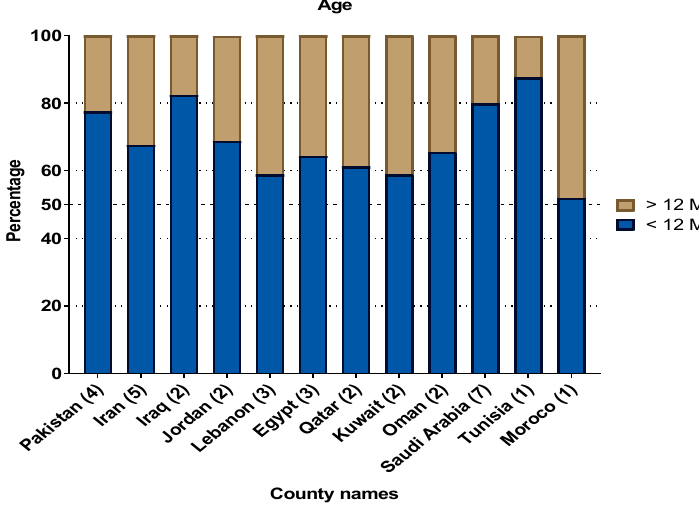
Figure 3. Age distribution of Respiratory Syncytial Virus (RSV) infections in the Middle East and North Africa (MENA) region: under 12 months of age (<12 M) and above 12 months of age (>12 M). Microorganisms 2020 , 8 , x FOR PEER REVIEW